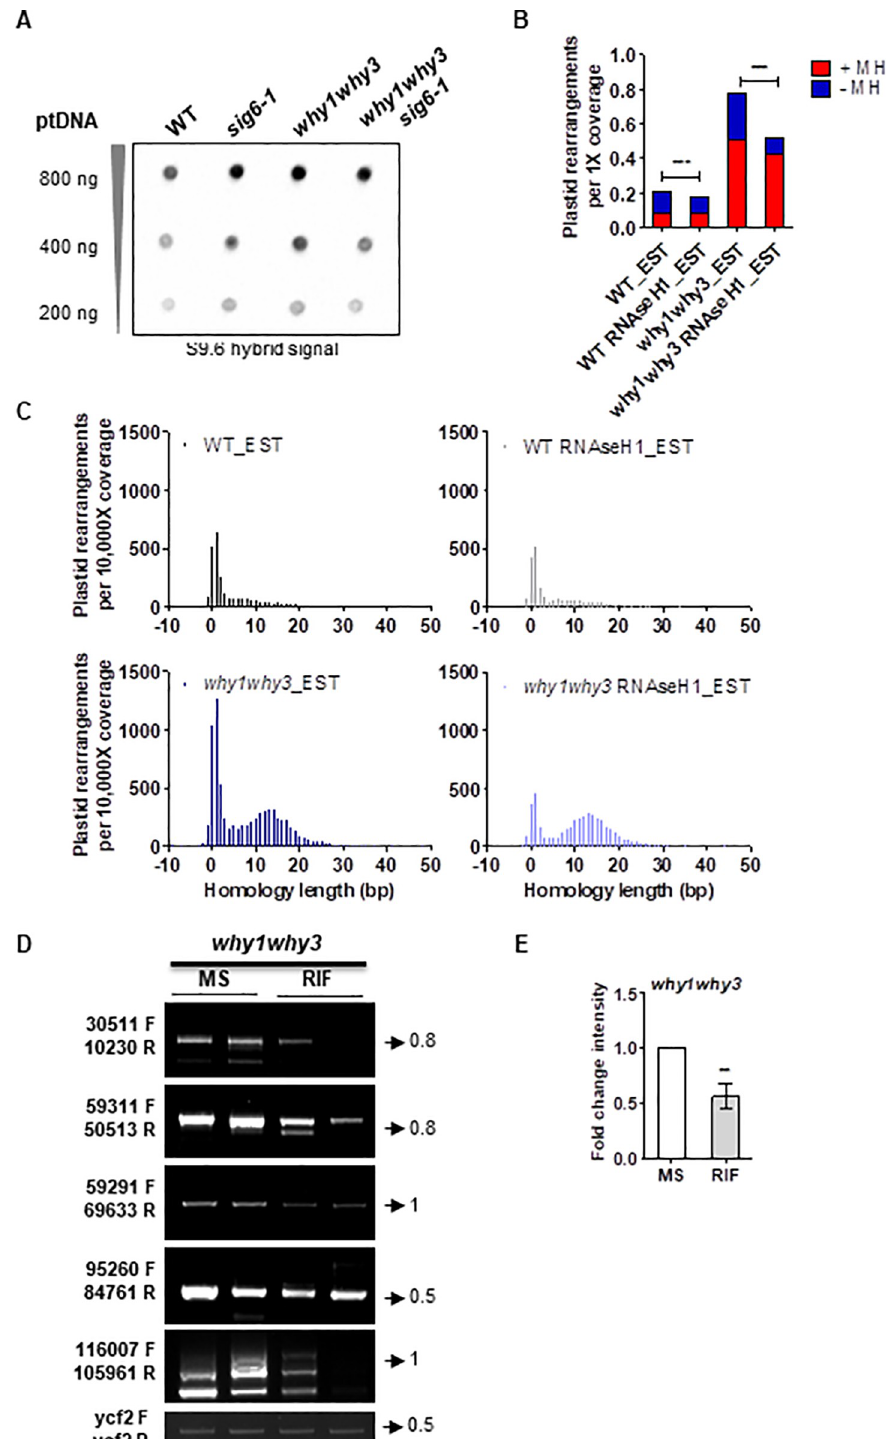
Fig 5. R-loops constitute a major threat to plastid genome stability. (A) Representative dot-blot showing the effect of SIG6 mutation on the accumulation of plastid R-loops. Plastid DNA was extracted from chloroplast of wild type (WT) and mutant plants grown for 14 days after germination (DAG) on soil, and serial dilutions were spotted and probed with the S9.6 antibody. Experiments were carried out on biological triplicates. (B-C) DNA-seq analysis of organelle rearrangements in wild type (WT), why1why3 , and transgenic plants expressing RNAse H1_A in the WT